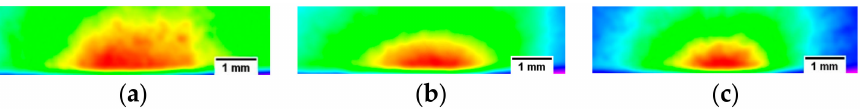
Figure 8. Two active nozzles with a substrate at 15 mm. Carrier mass flow = 1.08e − 0.4 kg/s, powder feed rate = 0.2 g/s: ( a ) shielding = 0 kg/s; ( b ) shielding = 3.9e − 0.4 kg/s; ( c ) shielding = 5.84e − 0.4